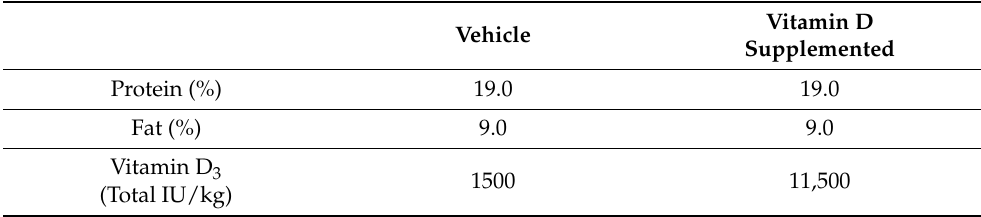
Table 3. Rodent diet